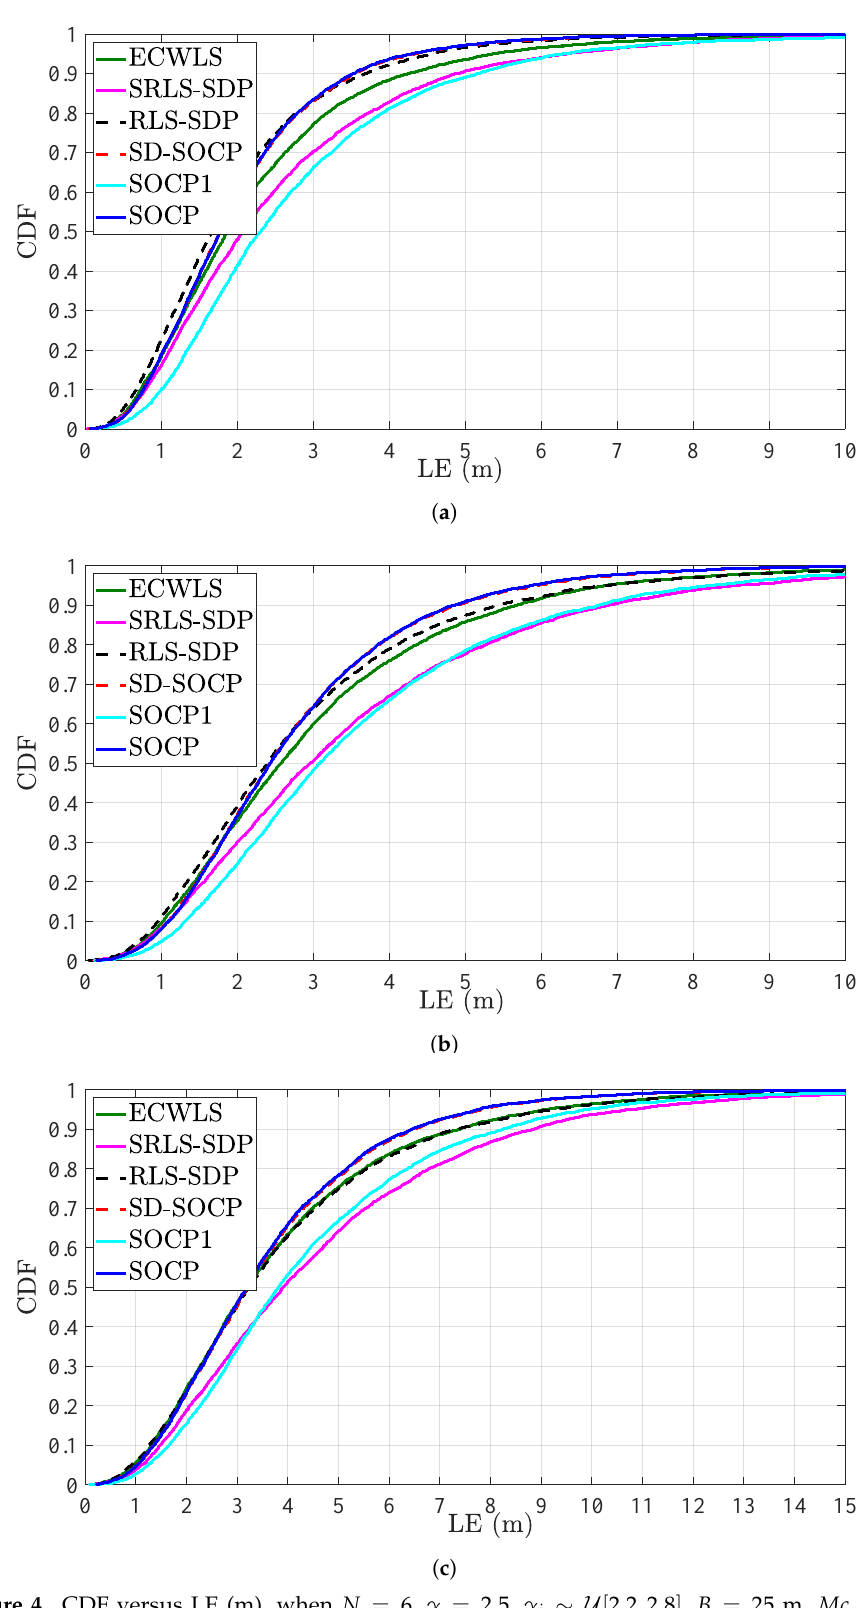
Figure 4. CDF versus LE (m), when N = 6, γ = 2.5, γ i ∼ U [ 2.2,2.8 ] , B = 25 m, Mc = 5000. = 4 dB, κ = 45.8447 (i.e., σ m = σ v = 6 deg). ( b ) σ n = 5 dB, κ ( a ) σ n i i i i i = σ v = 8 deg). ( c ) σ n = 6 dB, κ = 16.6760 (i.e., σ m = σ v = 10 σ m i i i i i i